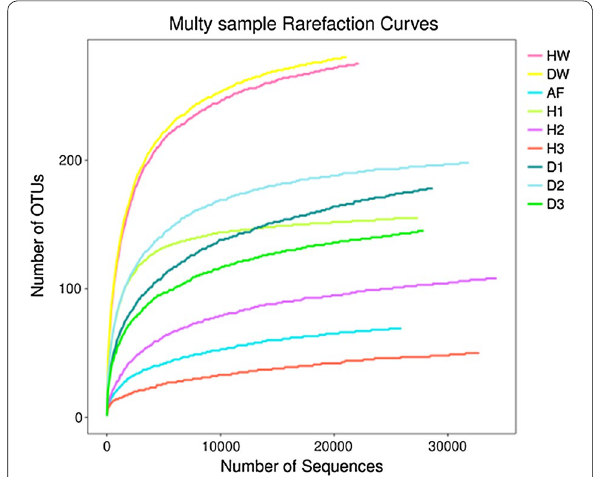
Fig. 1 Rarefaction curve. H1–H3 represent the intestinal microbiota of three healthy fish; D1–D3 represent the intestinal microbiota of